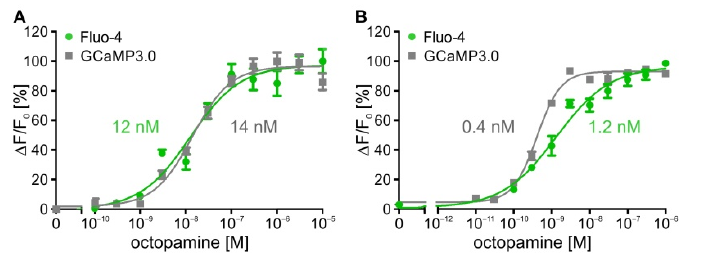
Figure 1. Concentration–response curves for octopamine on DmOct α 1B and flpTM-DmOct β 1 cells loaded with Fluo-4 or expressing GCaMP3.0. ( A ) Human embryonic kidney cells (HEK293) constitu- tively expressing DmOct α 1B receptors were either loaded with Fluo-4 (green) or stably transfected with GCaMP3.0 (grey); ( B ) Human embryonic kidney cells (HEK293) constitutively expressing DmOct β 1 receptors and CNGA2 channels (flpTM-DmOct β 1) were either loaded with Fluo-4 (green) or stably transfected with GCaMP3.0 (grey). Concentration-dependent effects of octopamine on [Ca 2+ ] i were determined. Relative change in fluorescence ( Δ F/F 0 ) is given as the percentage of the value obtained with the highest octopamine concentration (=100%). Octopamine activation of both receptors led to a concentration-dependent increase in the fluorescence signal. The increase in [Ca 2+ ] i in flpTM-DmOct β 1 cells is due to receptor-mediated production of cAMP and subsequent opening of CNGA2 channels causing Ca 2+ influx into the cell. During measurements with flpTM-DmOct β 1 cells, cAMP degradation was inhibited with 100 µM IBMX. A total of five independent measurements were performed. Data points represent the mean ± SD of a representative eight-fold determination.